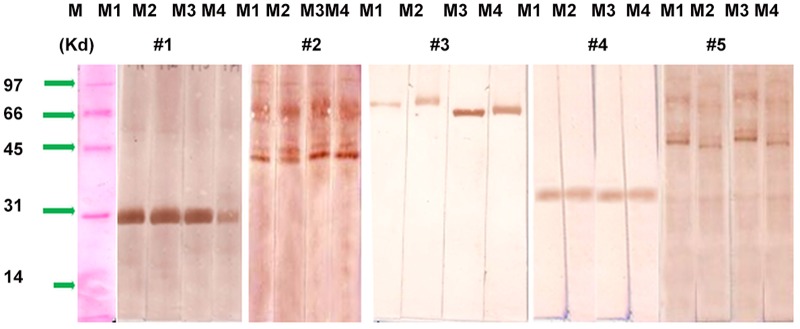
Immunoblot against against non GM and GM maize antigens in the sera of selected 5 maize sensitized patients using sera conc. of 1:10 v/v, to reveal IgE binding protein fractions.M1- Non GM maize, M2- GM + Cry 1Ac, GM + Cry 1Ab, M4—GM + Cry 1C. M- Protein marker.